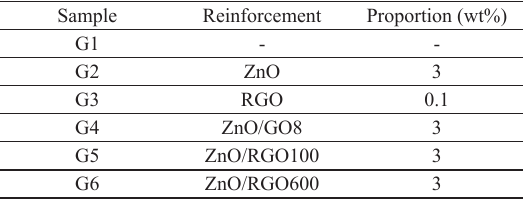
Table 1 - Glass ionomer reinforced